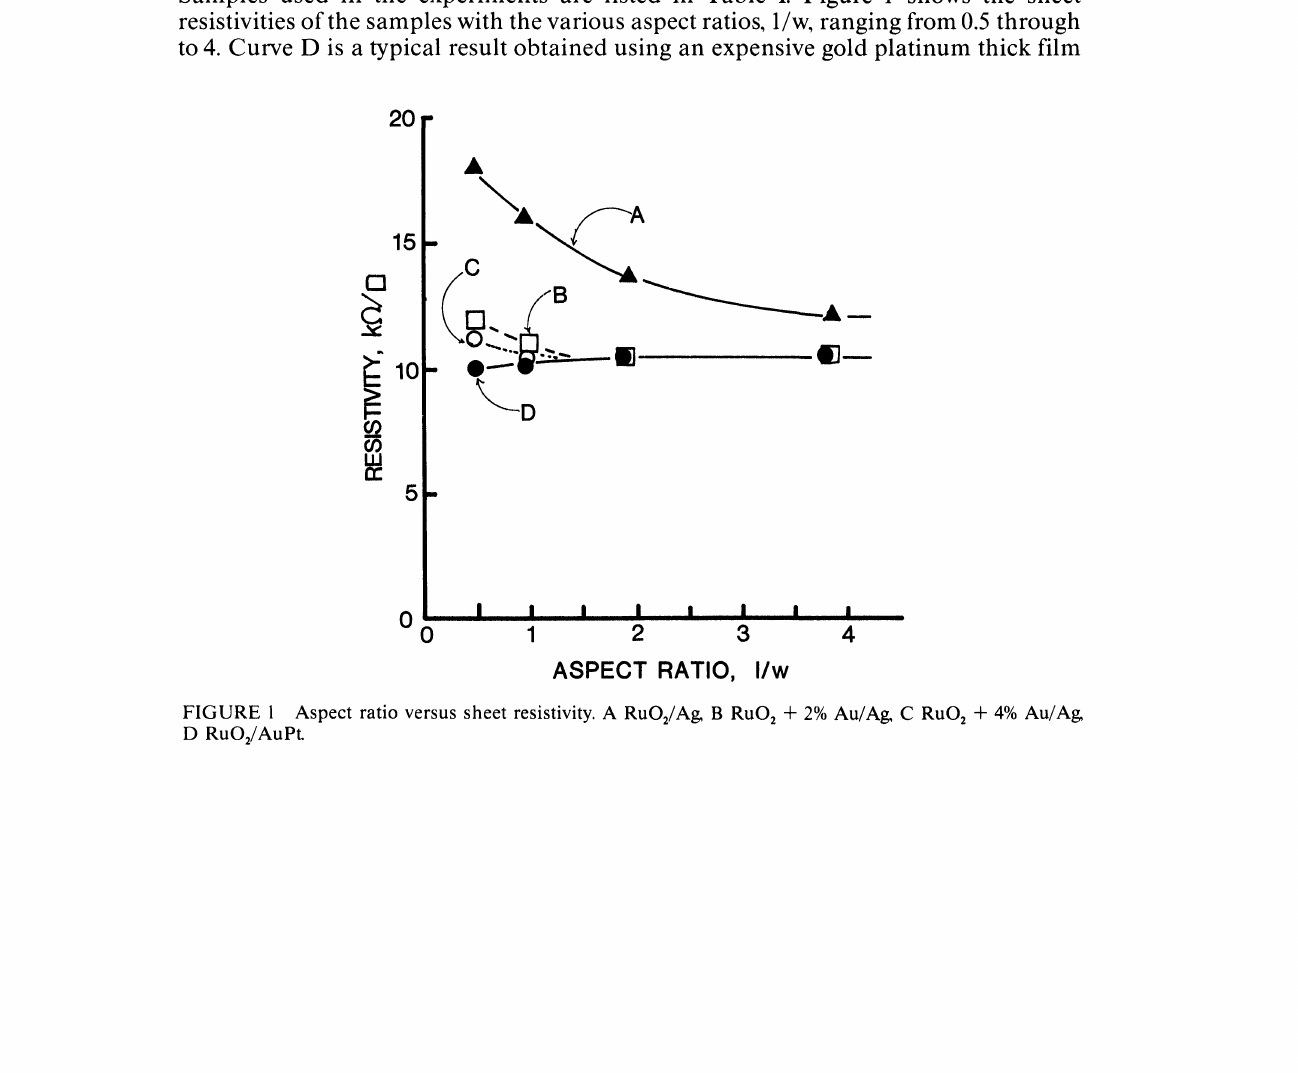
FIGURE Aspect ratio versus sheet resistivity. A RuO2/Ag, B RuO + 2% Au/Ag C RuO2 + 4% Au/Ag D